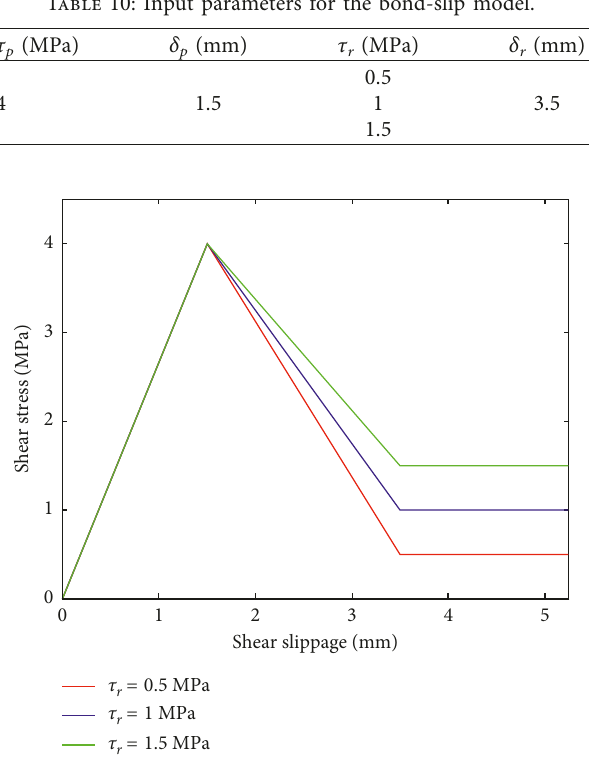
Figure 13: A plot of the input bond-slip model when the residual shear strength of the bolt/grout interface was different.